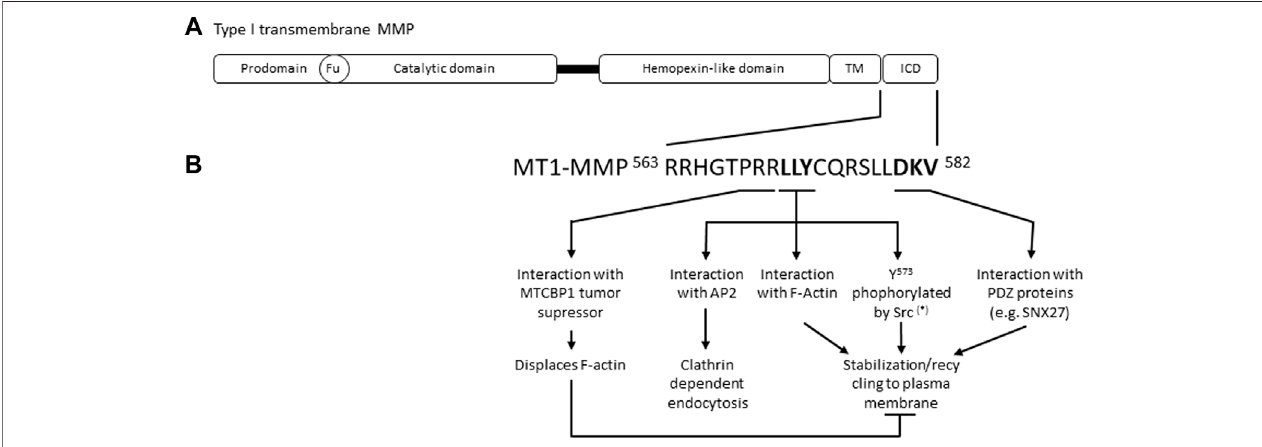
FIGURE 1 | (A) Schematic representation of type I transmembrane MMPs. Fu, Furin cleavage recognition site; TM, transmembrane domain; ICD, intracellular domain. (B) Main MT1-MMP intracellular domain molecular features reported to control MT1-MMP endocytic and exocytic cycles. (*) other